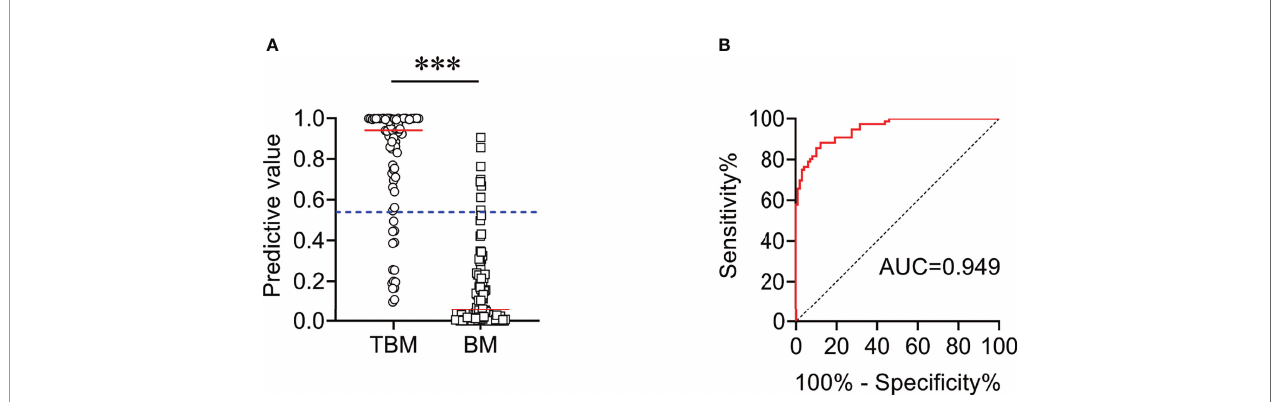
FIGURE 6 | The performance of diagnostic model for discriminating TBM from BM in Qiaokou cohort. (A) Scatter plots showing the predictive value of the diagnostic model in TBM patients (n = 76) and BM patients (n = 98). Horizontal lines indicate the medians. *** P < 0.001 (Mann – Whitney U test). Blue dotted lines indicate the cutoff value in distinguishing these two groups. (B) ROC curve analysis showing the performance of the diagnostic model in distinguishing TBM from BM. ROC, receiver operating characteristic; AUC, area under the ROC curve.